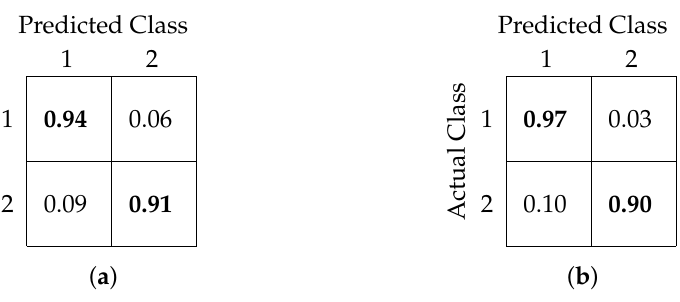
Figure 10. Confusion matrix for binary classification using ( a ) FCNN-based architecture and ( b ) CNN-based